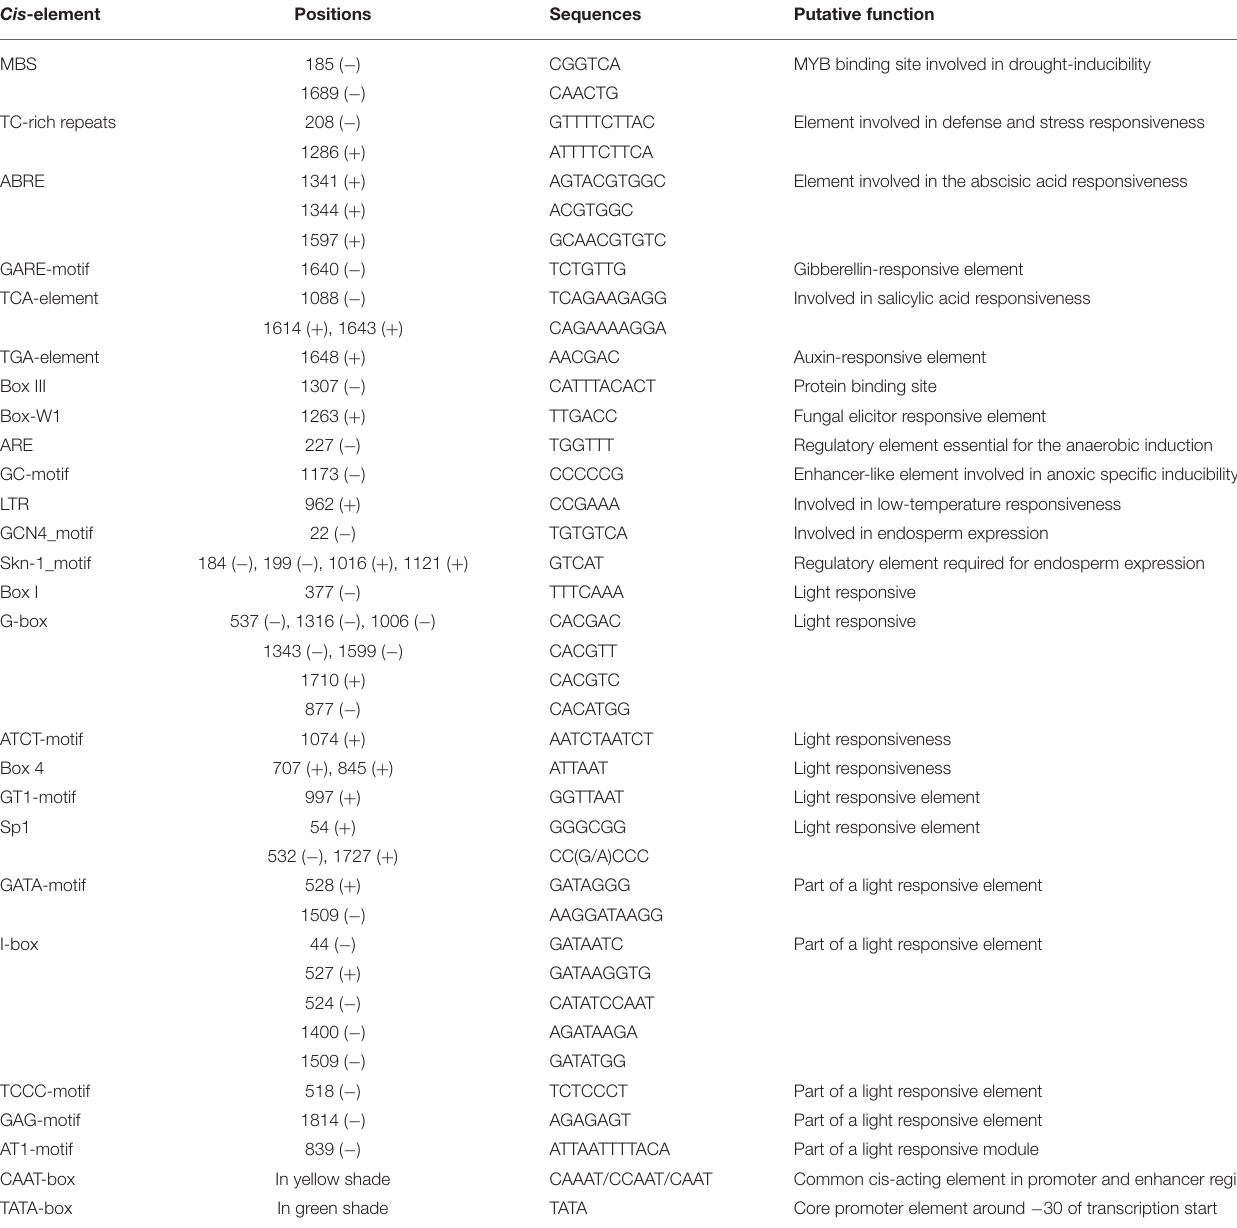
TABLE 3 | Predicted cis -regulatory elements with putative functions identified in promoter of MdATG8i using PLANTCARE